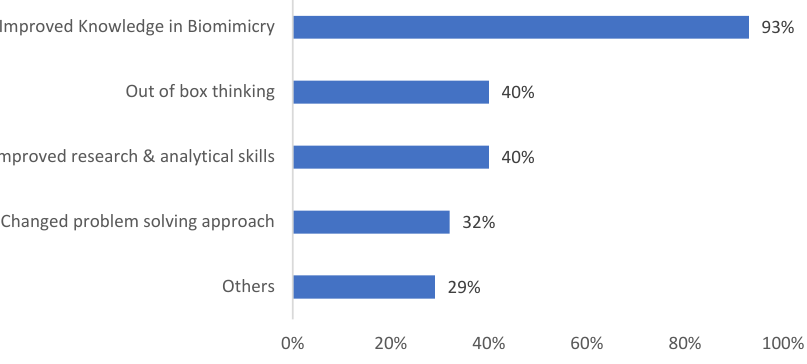
Figure 15. Student responses to how the N&A module changed their approach and thinking.